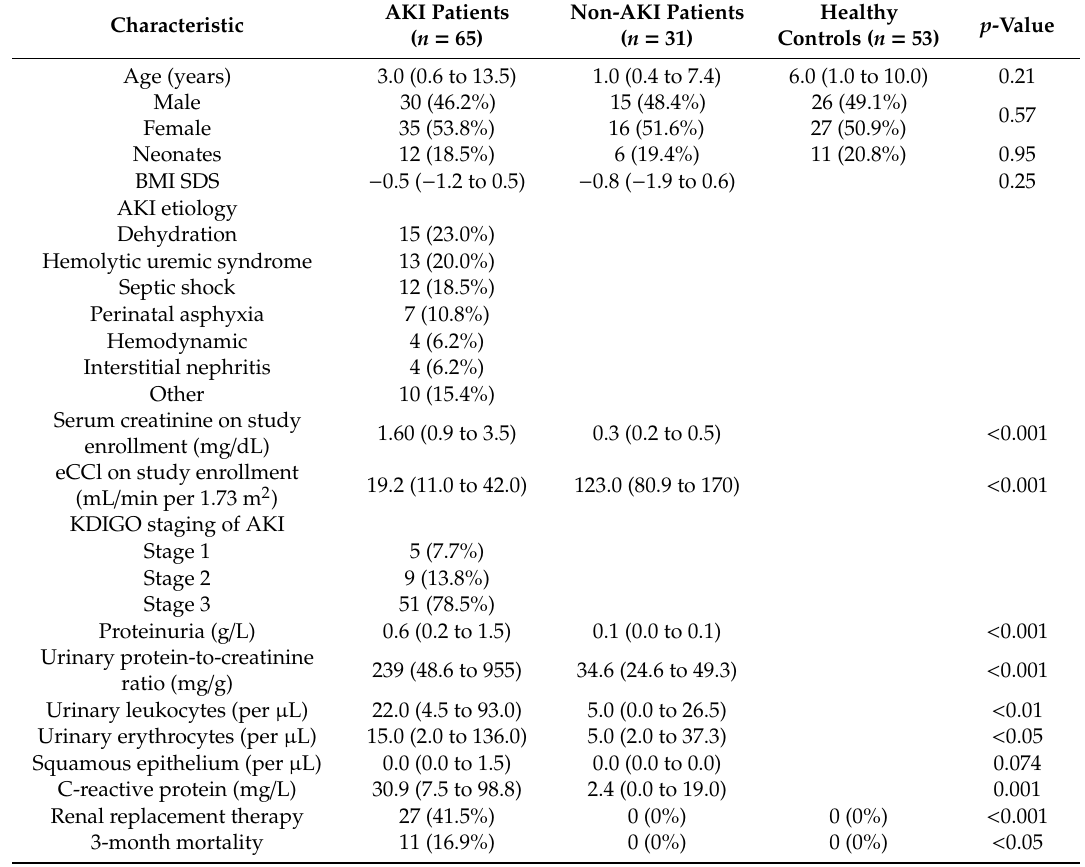
Table 1. Characteristics of the study population. Numeric data are presented as median with interquartile range (IQR) in parenthesis. Categorical data are presented as a number with the percentage in parenthesis. Statistical tests used for the individual parameters are described in the section Statistical Analysis. p < 0.05 was regarded as statistically significant. Abbreviations: AKI, acute kidney injury; BMI, body mass index; eCCl, estimated creatinine clearance; KDIGO, Kidney Disease: Improving Global Outcomes; SDS, standard deviation